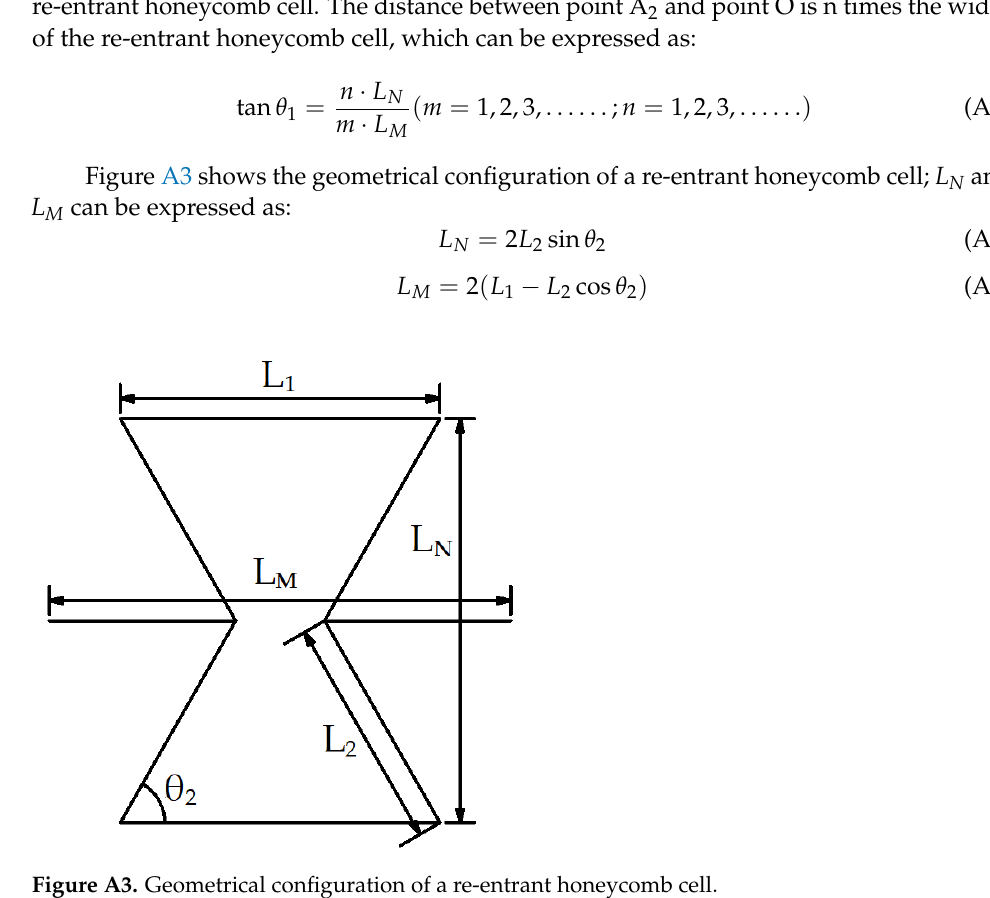
Figure A3. Geometrical configuration of a re-entrant honeycomb cell. Substituting (A2) and (A3) into (A1) provides: